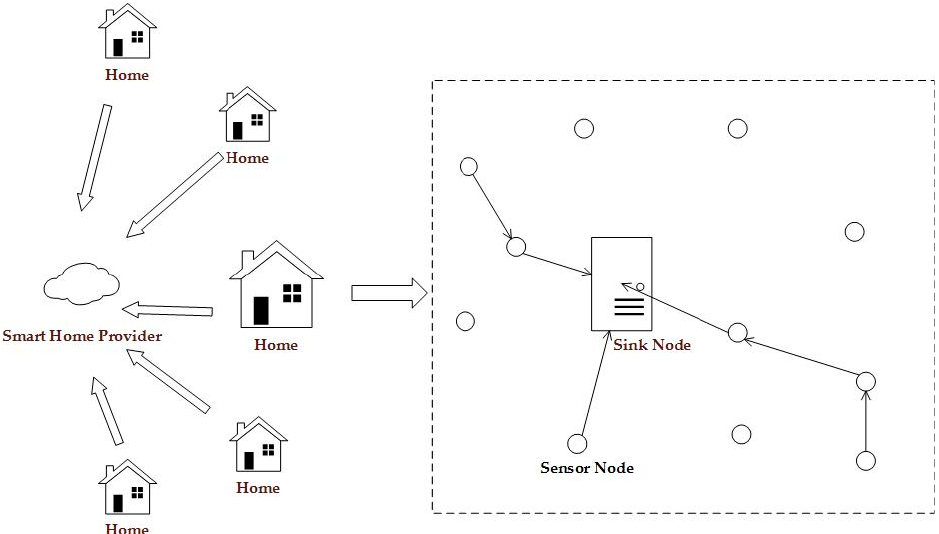
Figure 3. The framework of a smart home.